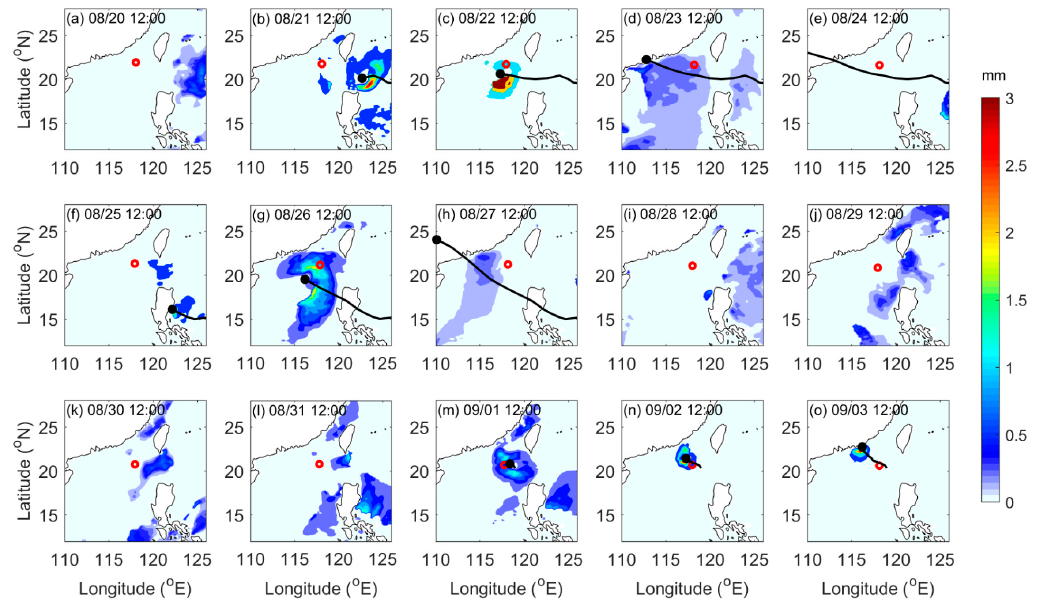
Figure 11. Ocean surface roughness (unit: mm) estimated by global wave model MFWAM products at 12:00 UTC between August 20 and September 03, 2017. The red hollowed dots depict the position of wave glider, the black lines depict the tropical cyclone tracks, and the black dots depict the centers of the tropical cyclones ( a – o ).